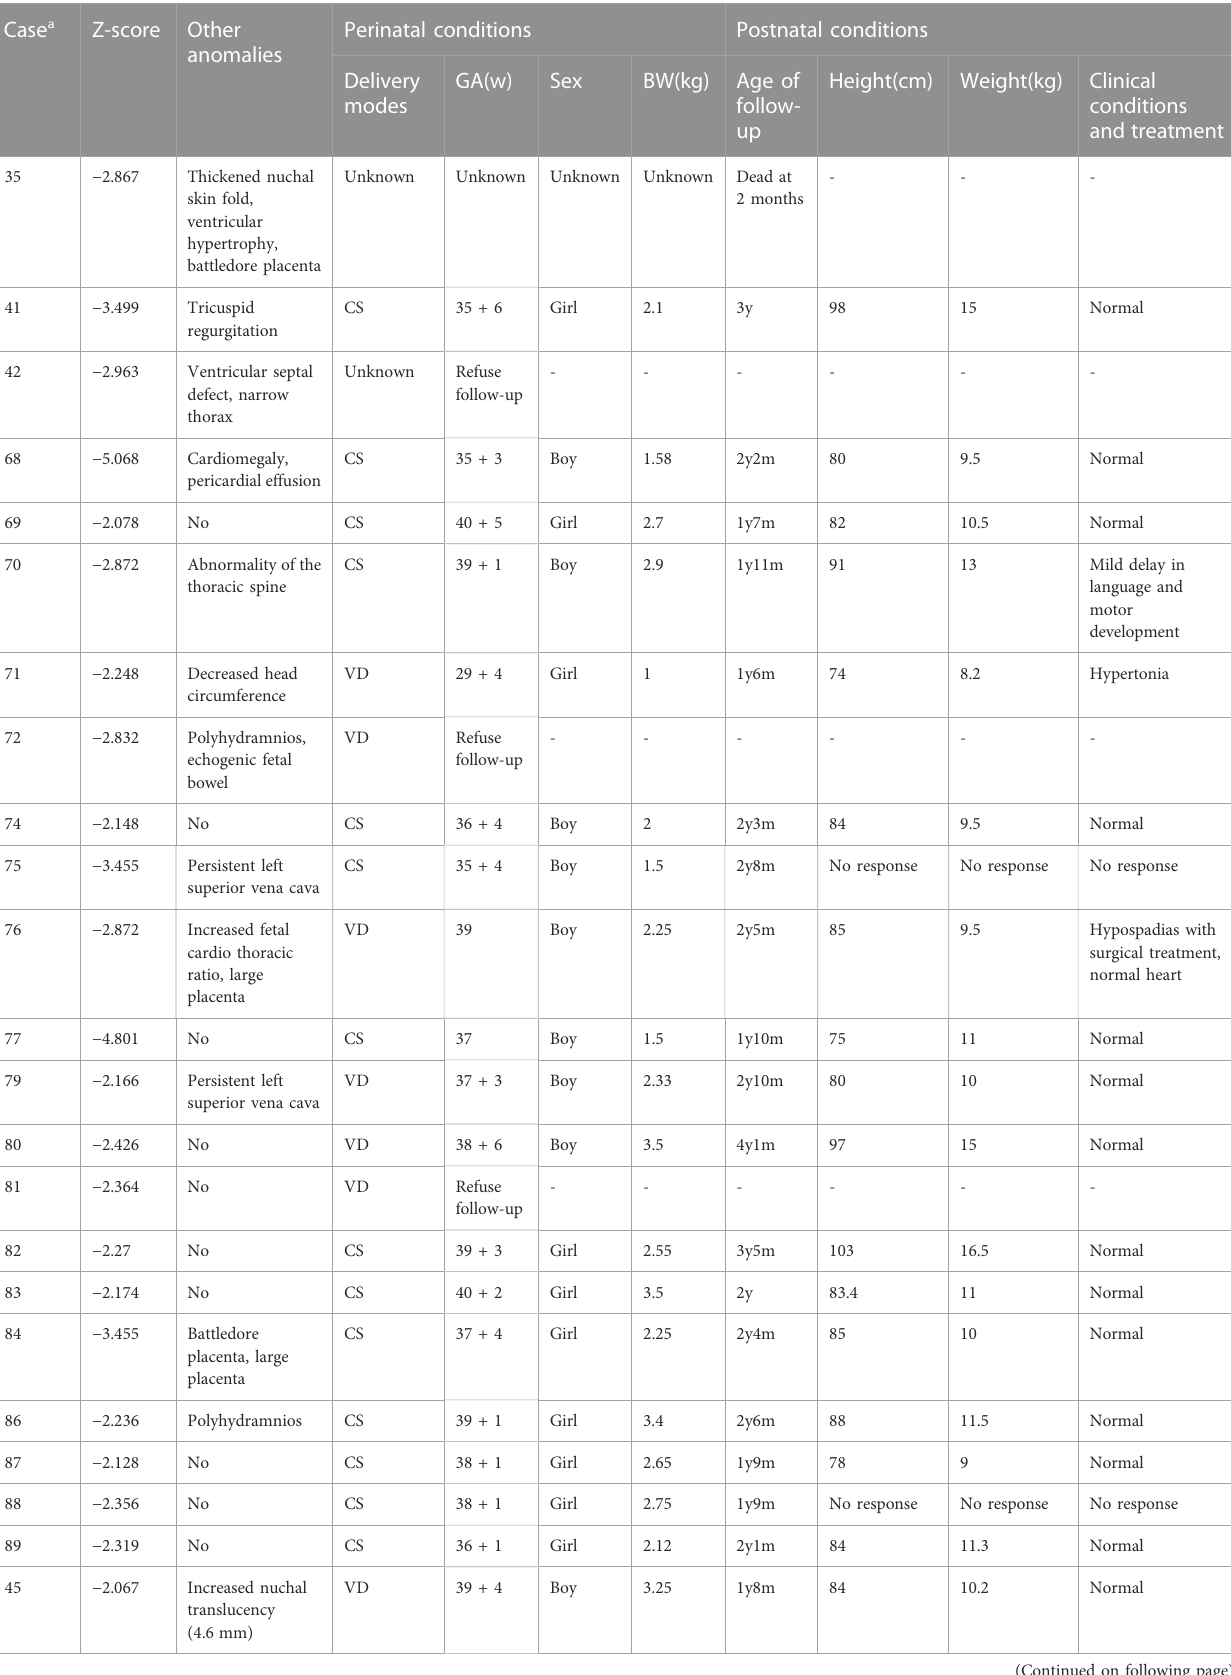
TABLE 5 Characteristics of clinically signi fi cant perinatal and postnatal conditions in 30 liveborns cases in whom follow up was ascertained. Case